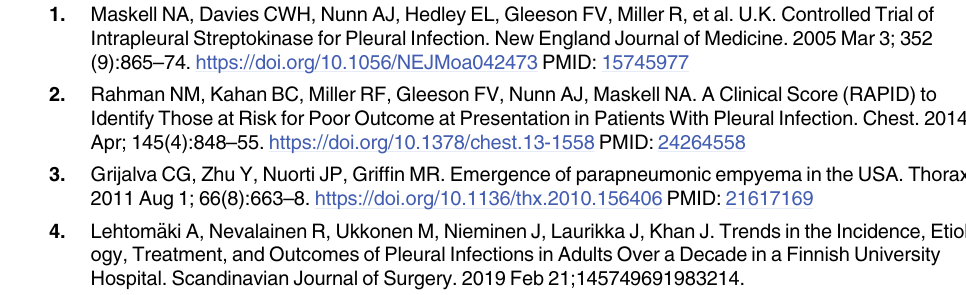
S1 Fig. Covariate balance of absolute standardized differences before and after overlap propensity score weighting comparing values between patients in RTT-U and RTT-UD groups. PS: Propensity-Score, RTT: Repeated Therapeutic Thoracentesis, COPD: Chronic Obstructive Pulmonary Disease. S2 Fig. Event free survival in pleural infections managed with RTT according to the puru- lence of the pleural fluid